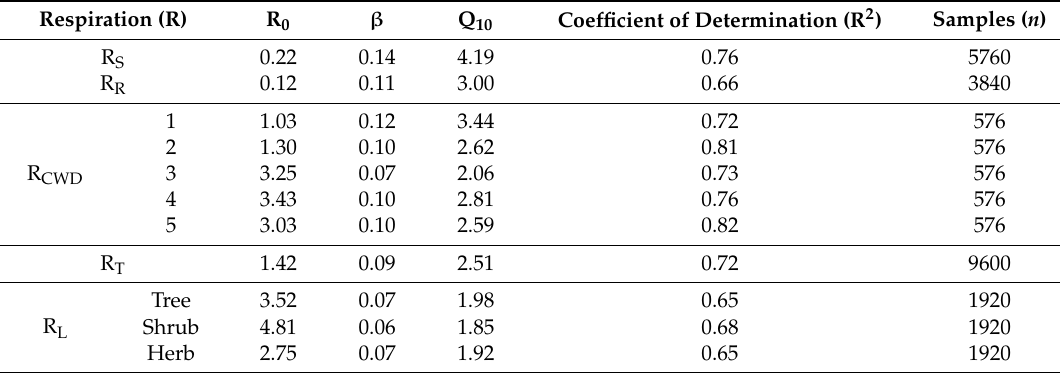
Table 1. Parameters in the temperature response function (Equation (4)) for soil respiration